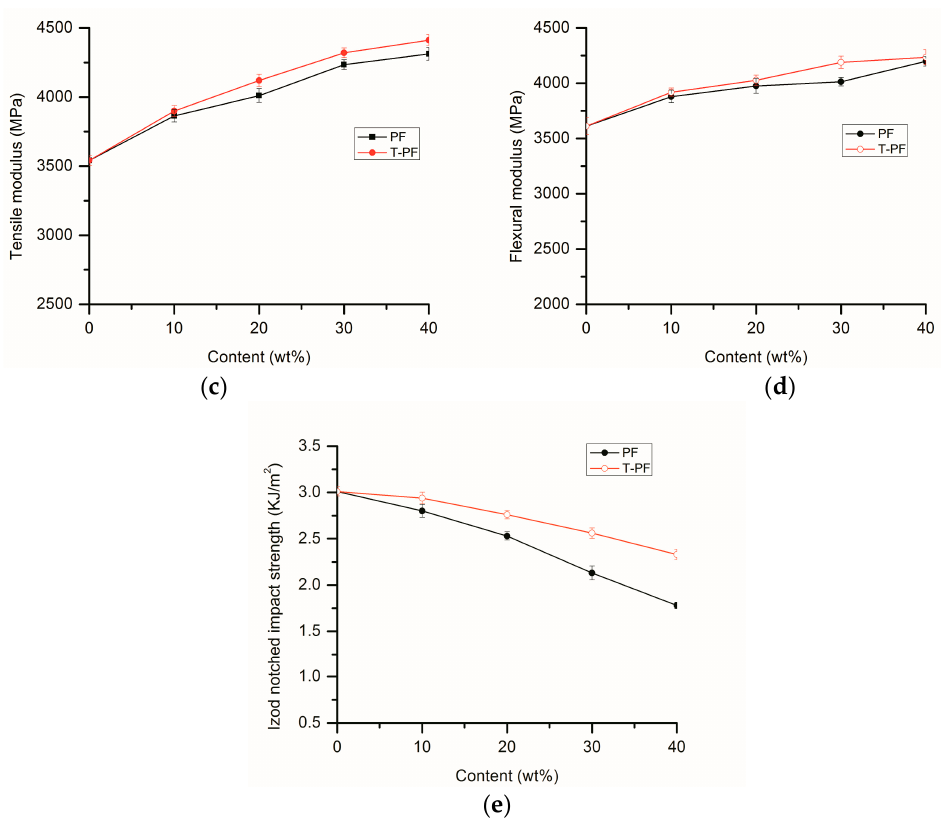
Figure 5. Mechanical properties of the eco-composites. ( a ) tensile strength; ( b ) tensile strain at break; ( c ) tensile modulus; ( d ) flexural modulus; ( e ) Izod notched impact strength.